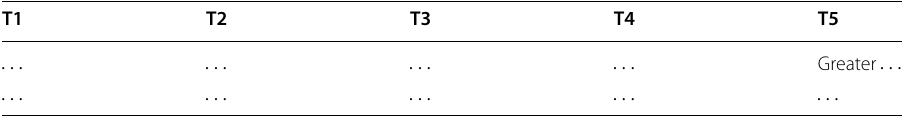
Table 5 Assessment (cumulative total duration)